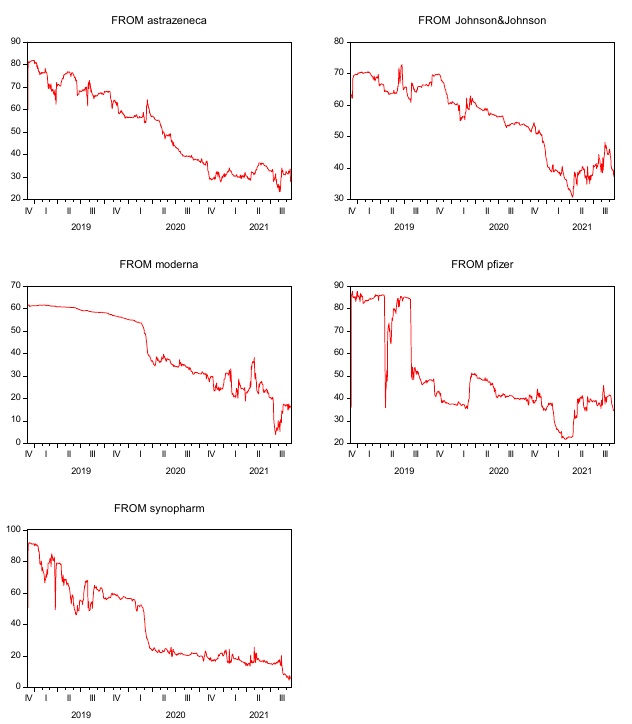
Figure A1. Volatility transmission from AstraZeneca, Johnson &Johnson, Moderna, Pfizer and Si- nopharm.